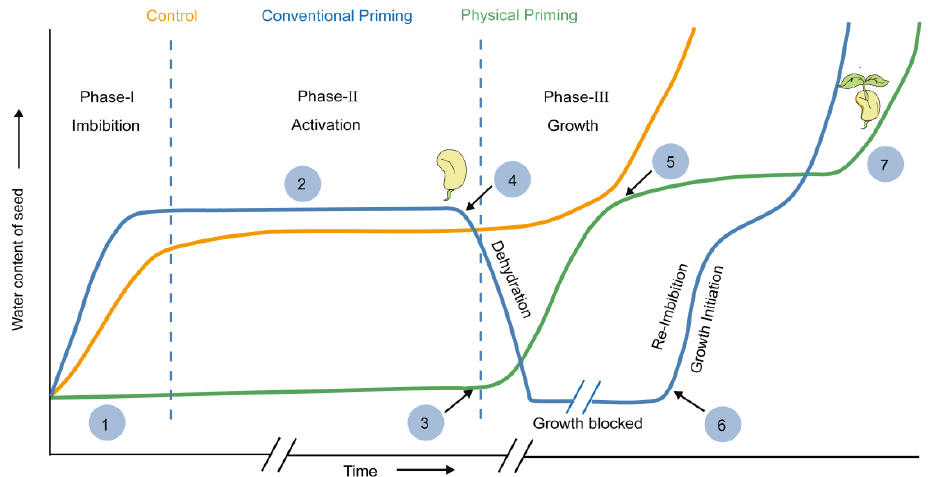
Figure 2. Schematic representation of the water uptake within the seed during germination in control, conventionally primed, and physically primed seeds. There are three stages in seed germination process: the first phase (imbibition phase) starts with the absorption of water, the phase II (metabolic activation) involves the activation of the enzymes, and this dramatically increases respiration and metabolism, and phase III (radical protrusion phase) mainly involves a process which regulates the cell elongation and the roots and hypocotyls protuberance from the seeds. The seed priming strategies principally occur during phase II, which stimulates the uptake of water and accelerates the pregerminative metabolic process. The yellow line represents a standard (control) germination process. The blue line corresponds to a conventional primed seed germination process. The green line (hypothetical) represents germination in the physical primed process. The figure is adapted from [3,10]. 1 (cid:13) Initiation of seed priming. 2 (cid:13) Energy metabolism, regulation of oxidative status, DNA repair, cell cycle activation, food reserve mobilization, alteration of hormonal status, de novo synthesis of mRNA for metabolic genes, synthesis of HSPs which probably protect cell proteins from damage and free radical scavenging enzymes which possibly protects the cell from damage due to lipid peroxidation. 3 (cid:13) Imbibition. 4 (cid:13) Denouement of conventional priming followed by drying. 5 (cid:13) Rapid cell division and elongation. 6 (cid:13) Storage of conventional primed seed. 7 (cid:13) Final